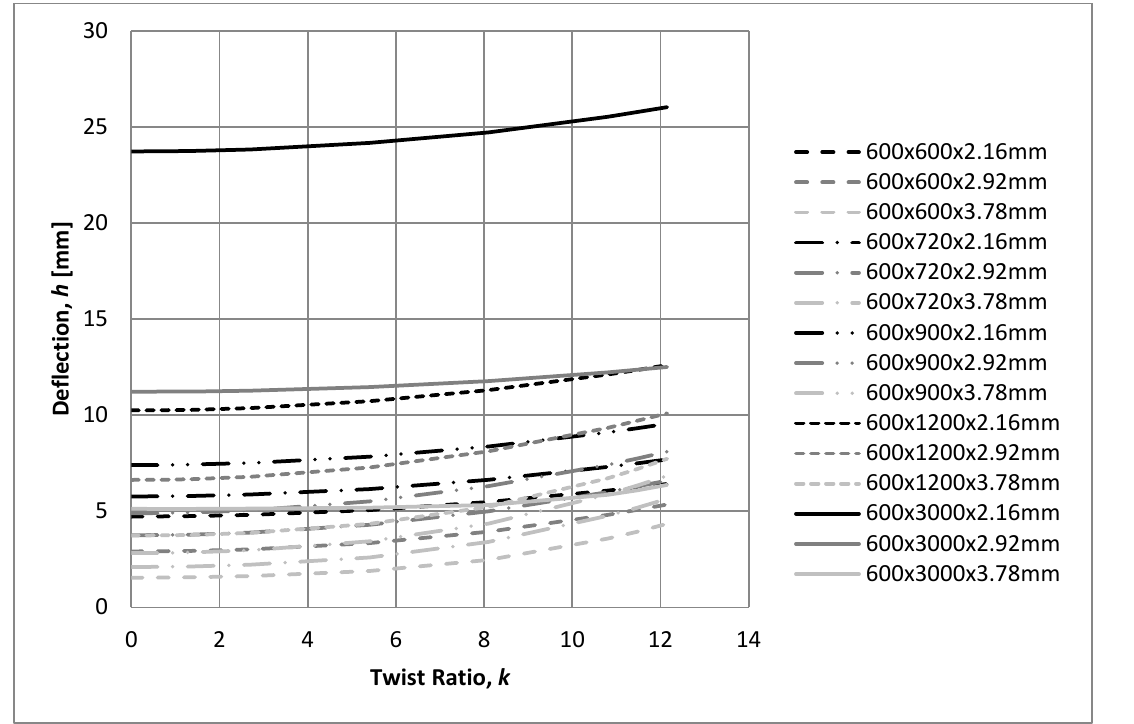
Fig. 6 Transverse deflection of 600mm wide specimens at 1.0 kPa